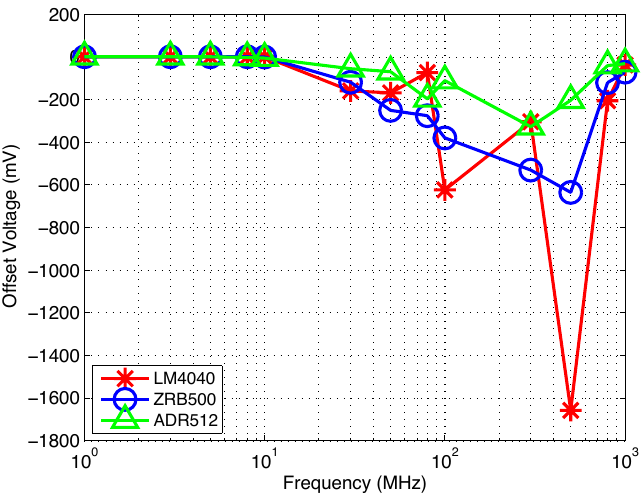
Figure 8. EMI induced offset in shunt voltage references: interferences coupled to the output